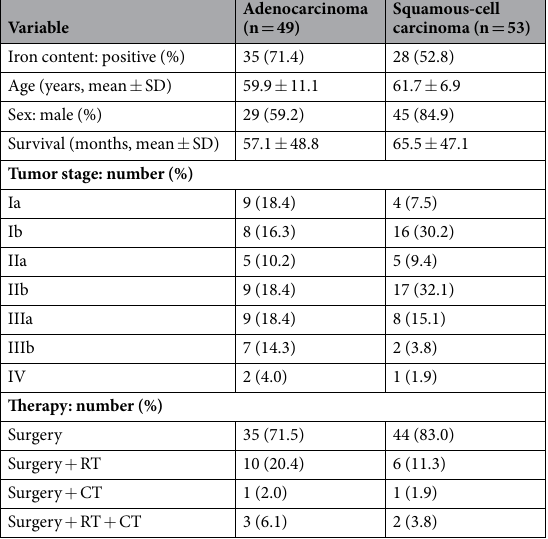
Table 1. Patient characteristics. Data are shown as absolute and relative frequencies or mean ±